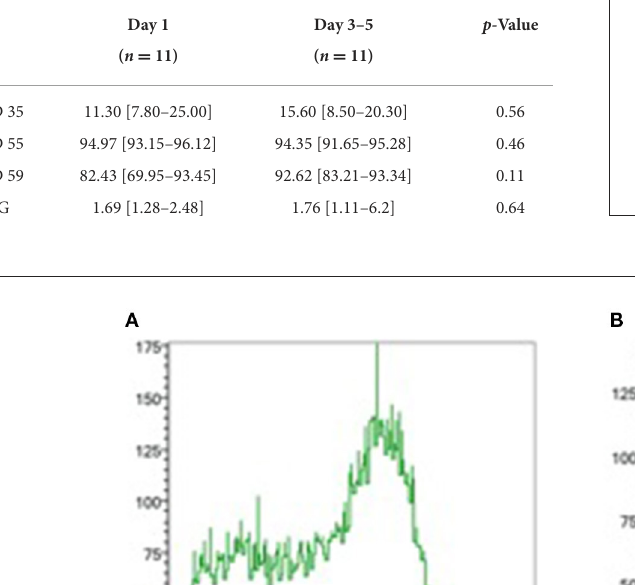
TABLE 3 Evolution of the receptor membrane receptor proteins and Ig G in septic patients at day 1 and 3–5 ( n = 11).